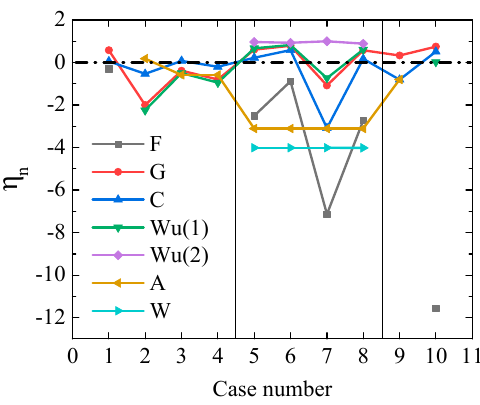
Figure 7. η n value analysis diagram.